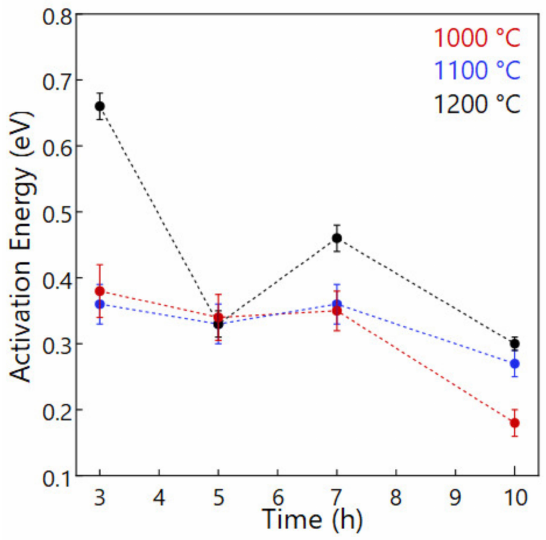
Figure 10. Activation Energy of the